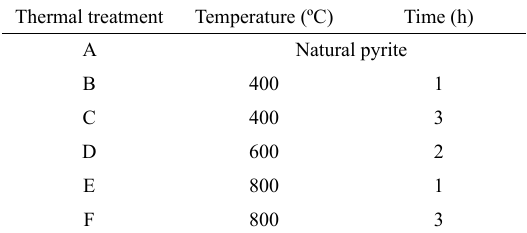
Table 1. Thermal treatment